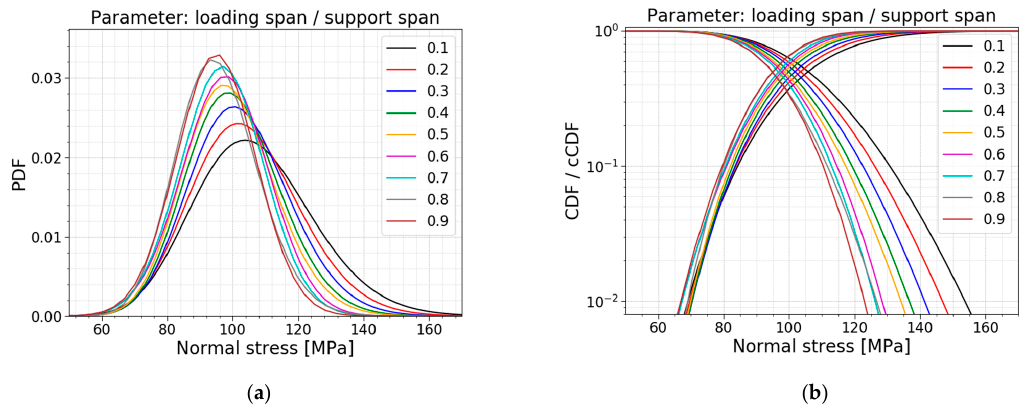
Materials 2023 , 16 , 2067 Figure 19. ( a ) PDF and ( b ) CDF for a varying ratio of the loading span to the support span.